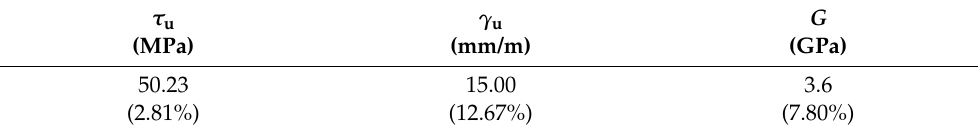
Table 5. In-plane shear properties of the GFRP webs (adapted from